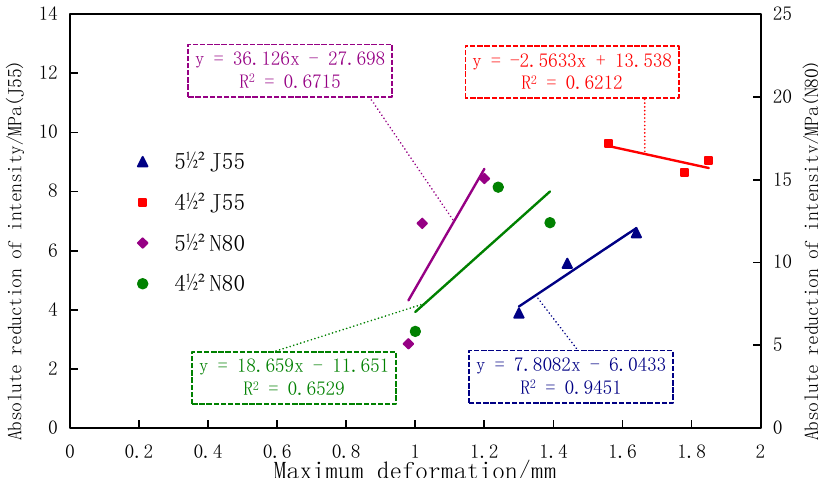
Figure 21. Relationship between absolute intensity-reduction value and maximum deformation.